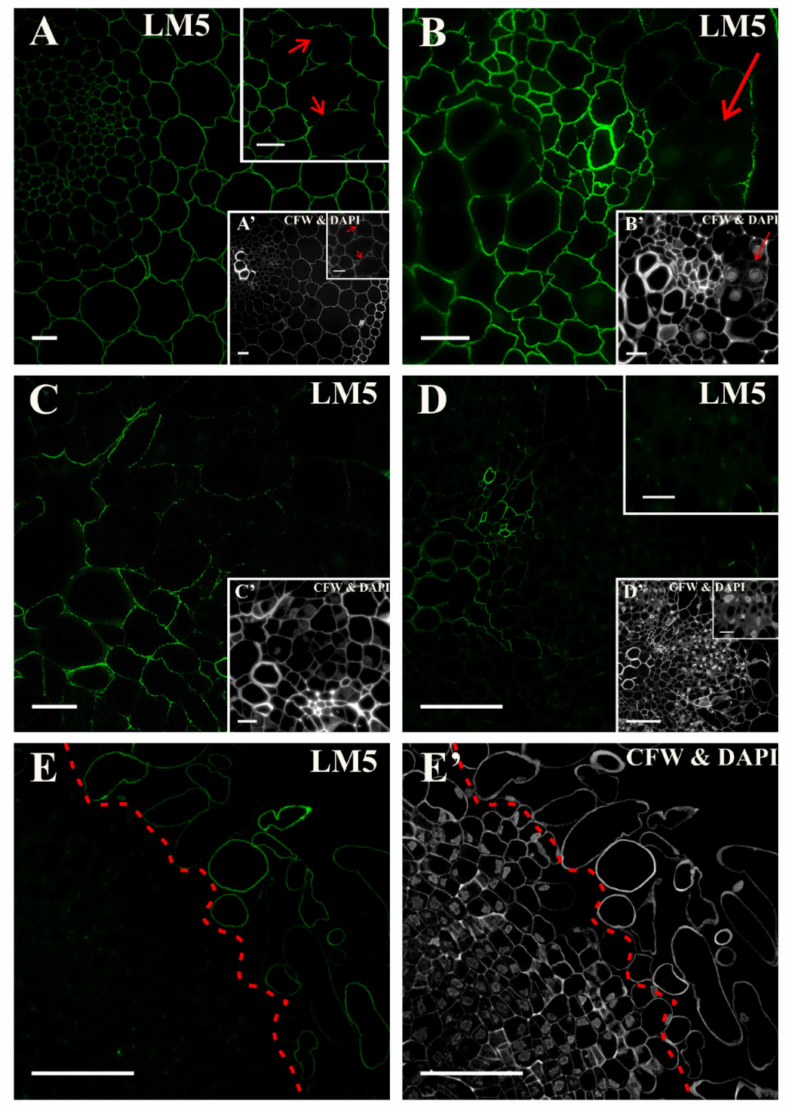
Figure 1. Distribution of the pectic epitope that is recognized by the LM5 antibody at di ff erent time points of the culture. ( A ) At the beginning of the culture continuous signal in the cell walls of all of the tissues except for the anticlinal walls of the pericycle cells that were located on the xylem side was detected (arrows, inset). ( B ) The hypocotyl after two days of culture with a clear signal in the cell walls of the vascular bundle, and almost lack of signal in the walls of the dividing cells (arrow). ( C ) After four days of the culture, the signal was detected in the cell walls of the vascular bundle; in the walls of the cells that had divided, the signal was almost not detected. ( D ) After five days of the culture, the signal was not detected in the walls of the dividing cells (inset). ( E ) On day 18, a clear signal characterized the walls of the separated cells. The dashed line separates the location of the epitope. ( A’ – E’ ) Calcofluor white (CFW) and DAPI staining of the section shown on A – E . Scale bars: A , A’ —20 µ m; inset—10 µ m; B , B’ ; C , C’ —10 µ m; D , D’ —50 µ m; inset—10 µ m; E , E’ —50 µ